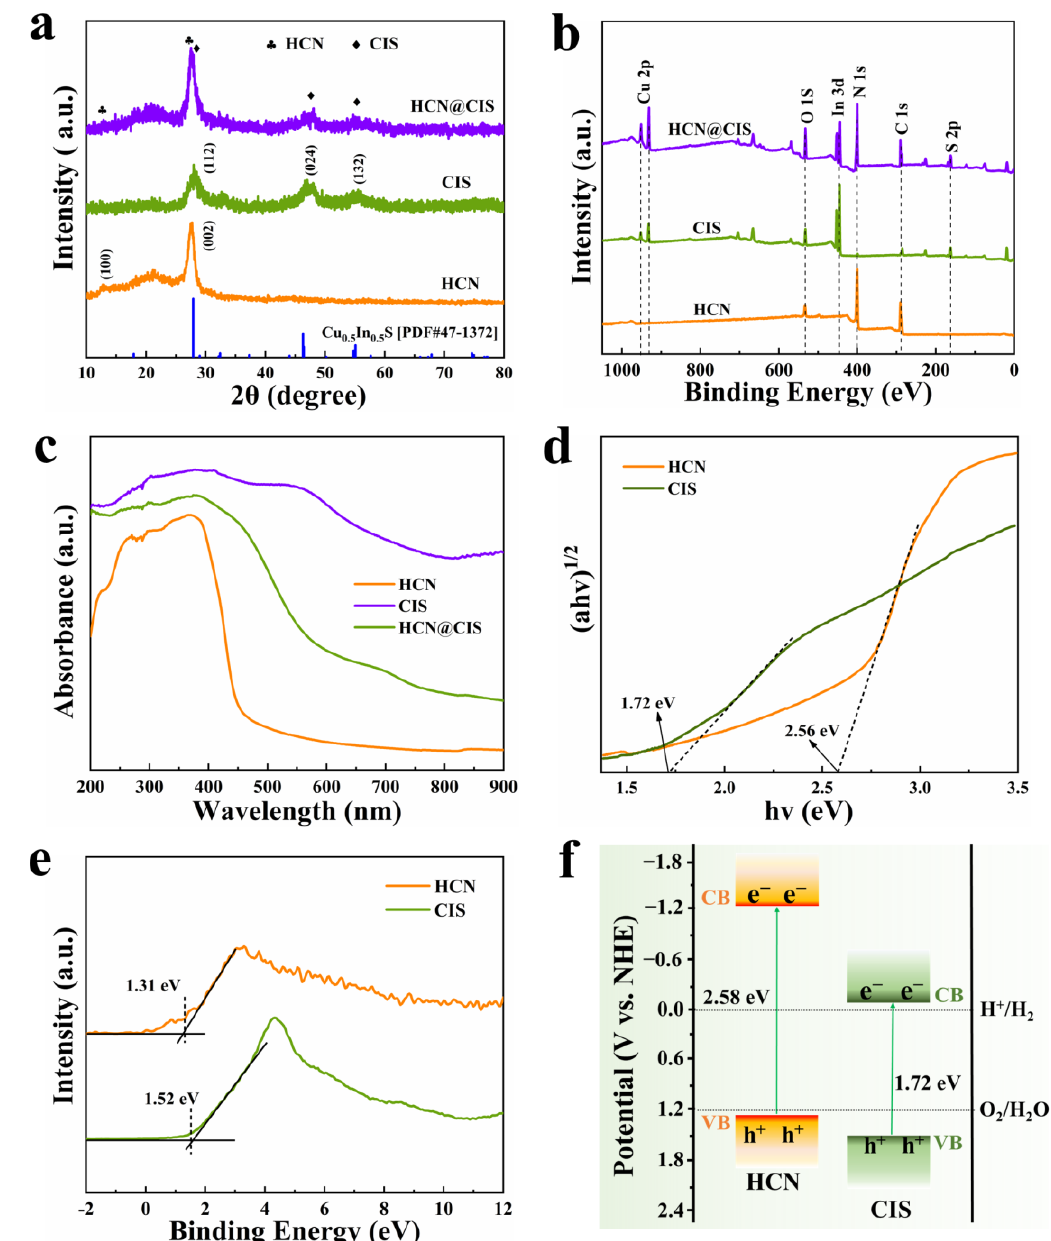
Figure 2. XRD pattern ( a ), XPS spectra ( b ), and UV-vis spectra ( c ) of HCN, CIS, and HCN@CIS. Tauc plots ( d ) and VB-XPS spectra ( e ) of HCN and CIS. Band structure alignments of HCN and CIS ( f ).